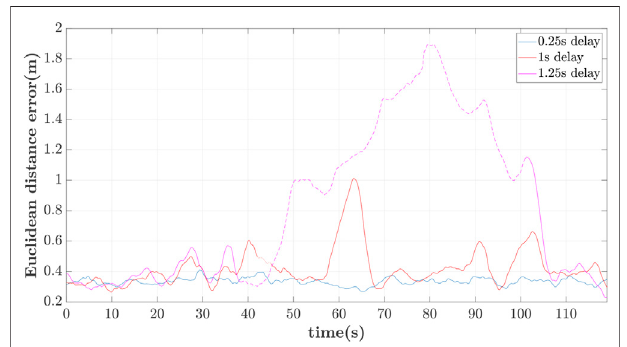
FIGURE 14 | Follower ’ s Euclidean distance error vs. delay.